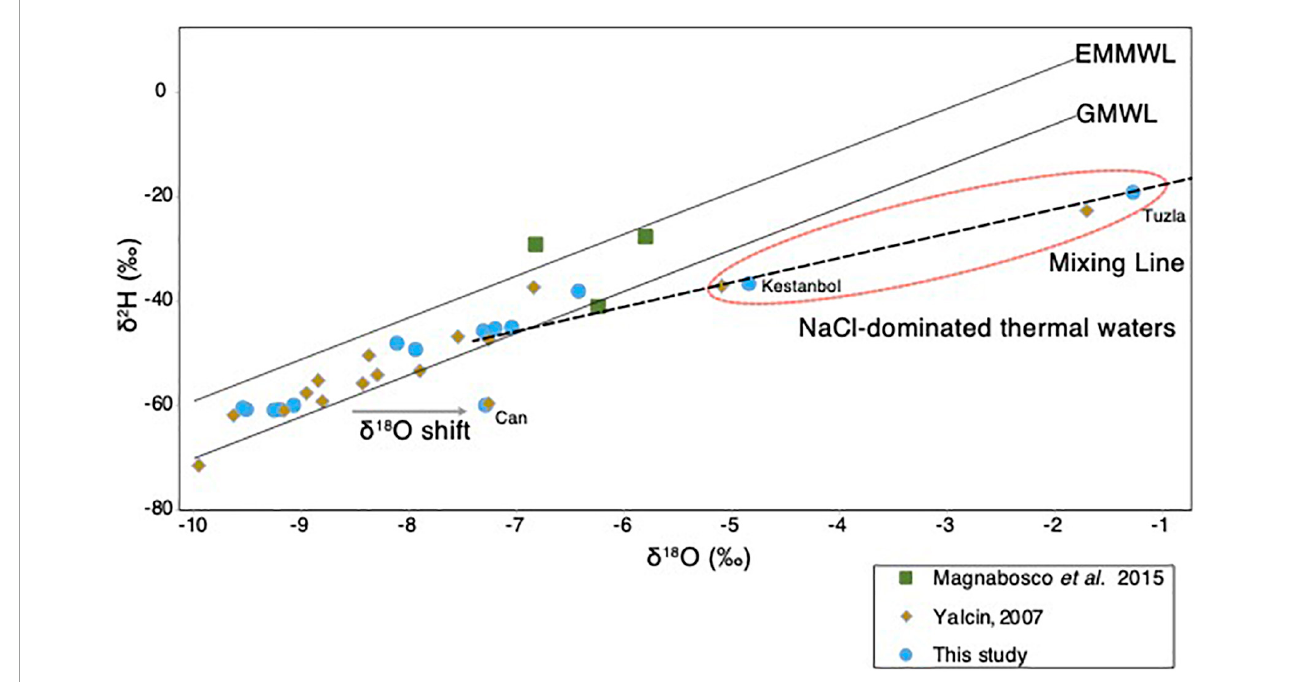
FIGURE3 Isotopic composition of the geothermal waters. The δ 2 H ( 2007; Magnabosco et al., 2016). The GMWL and EMMWL stand for Global Meteoric Water Line (Craig, 1961) and East Mediterranean Water Line (Gat and Carmi, 1970). The hypersaline brine waters at the Tuzla site ( Figure 1 ) that do not fall on the EMMWL or GMWL are highlighted in red